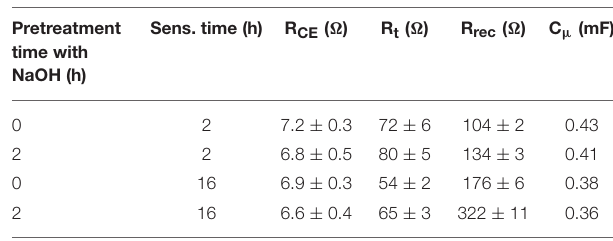
The relative error on C µ is lower than 0.01